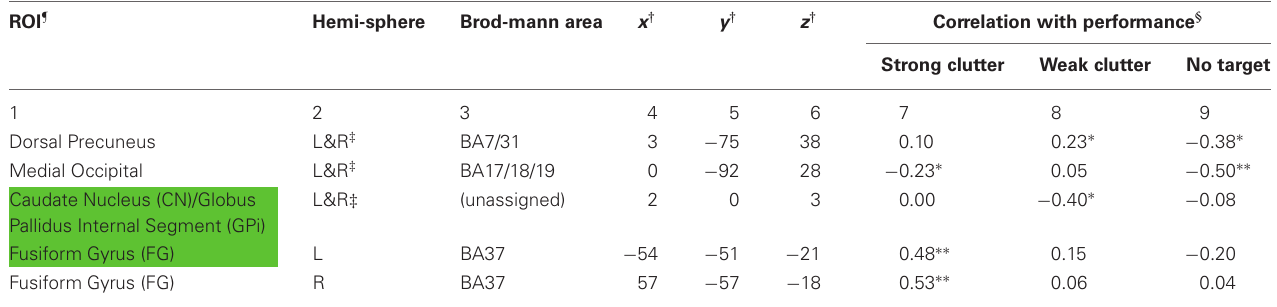
Table 2B | Learned in weak clutter > Learned in strong clutter ( p < 0 . 05, corrected).